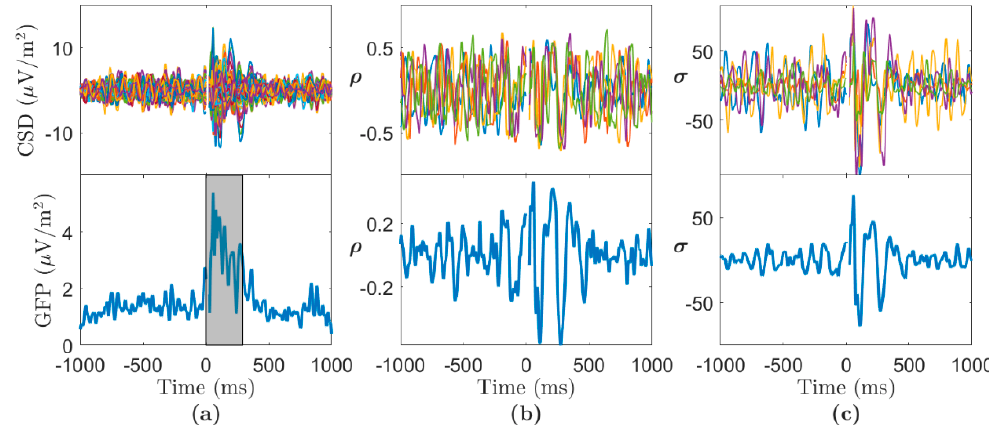
Figure 2. ( a ) Average TEP across subjects on top and GFP on bottom, ( b ) Correlation 𝜌 of CSD and E-field values for all subjects on top and their average on bottom, ( c ) same as ( b ), for covariance 𝜎 .